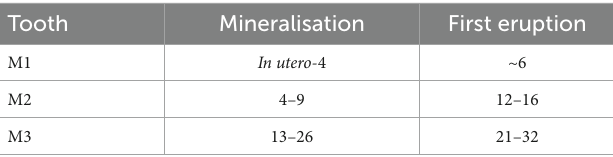
TABLE 1 Red deer crown estimated mineralisation and eruption periods in months (Brown and Chapman, 1991). Tooth